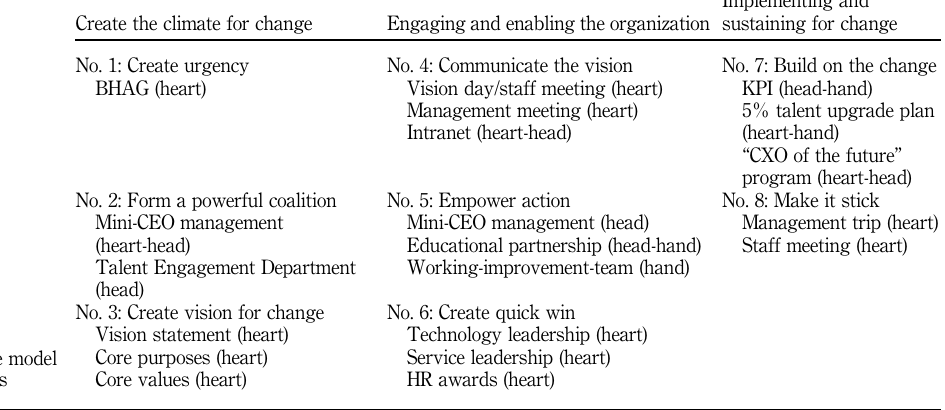
Table I. Kotter ’ s change model with 3-H